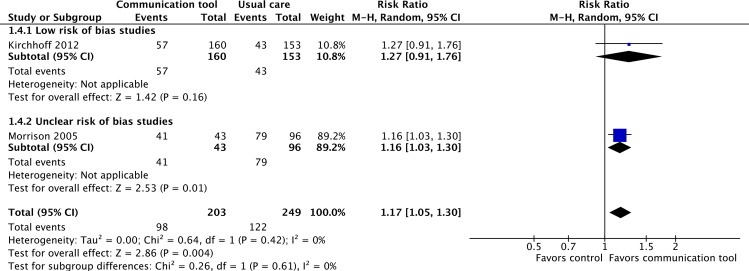
Quality of communication between patient and substitute decision-maker (SDM)—concordance between patient and SDM for level of care desired at end-of-life.